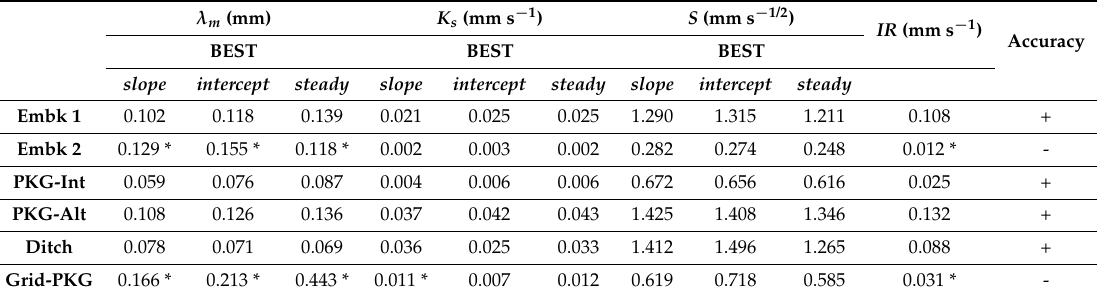
Table 4. Comparison of the observed infiltration rates to the obtained values of parameters K s , S , and λ m